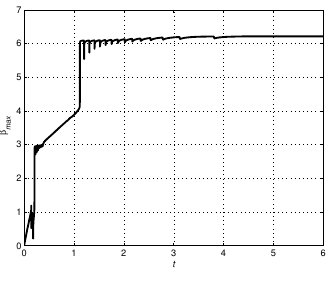
Figure 14. The dependence of max β on t for ωτ = 0 ⇒ 8, (cid:15) = 0.